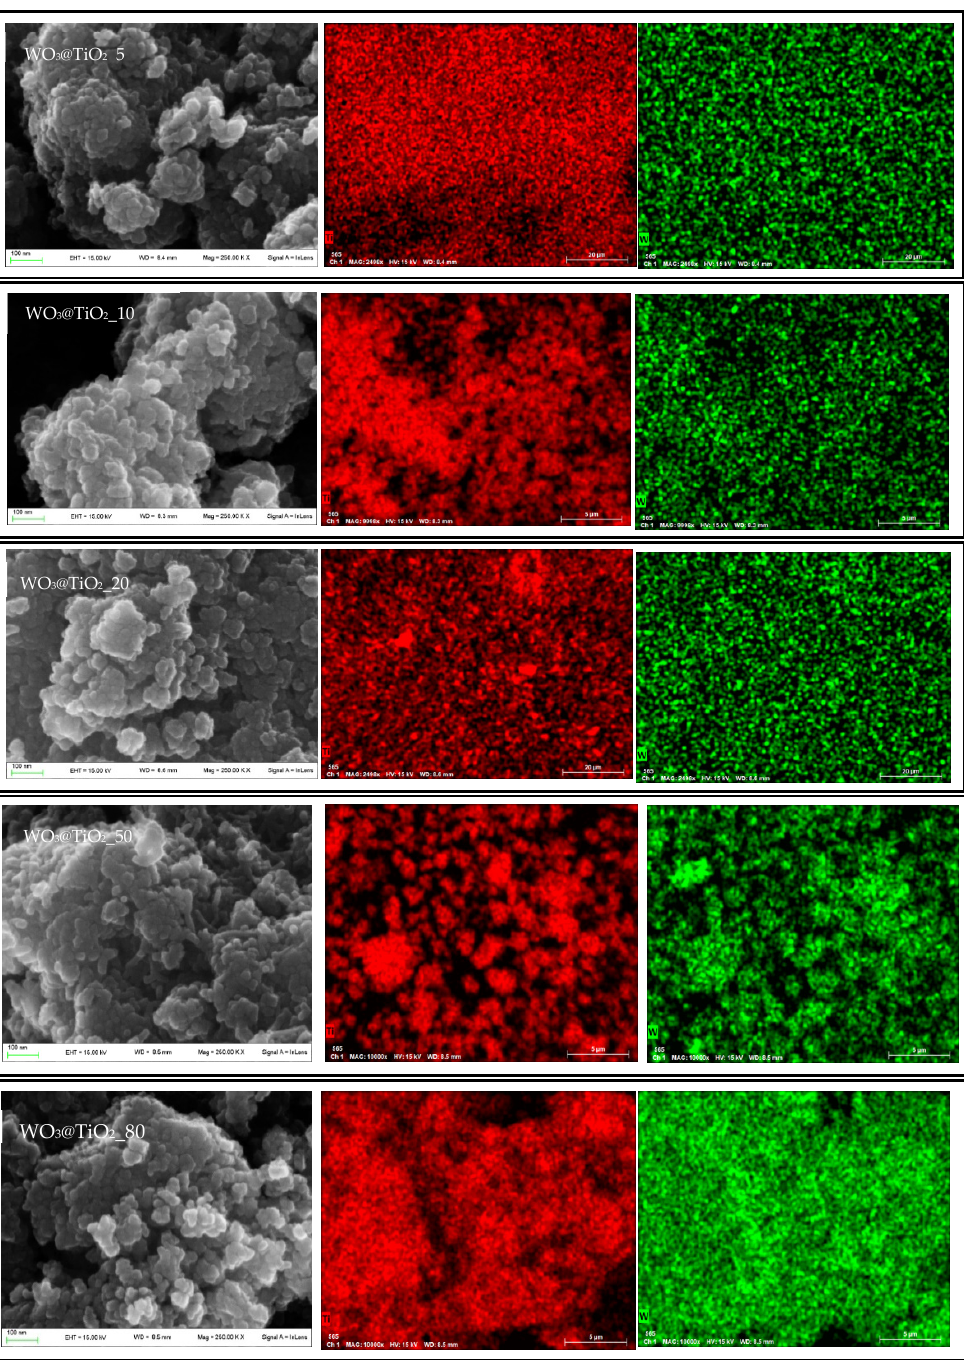
Figure 6. SEM images and elemental mapping of the synthesized materials. ( left ) sample analyzed, ( middle , red-colored) titanium map, ( right , green-colored) tungsten map. The elemental maps of W and Ti by X-ray energy dispersion (EDX) in the composites demonstrate that TiO 2 and WO 3 are well dispersed in each material. All the WO 3 @TiO 2 show a globular-like morphology with particle sizes ranging from 60 to 5 nm. The particles are aggregated by sharing corners or edges that probably involve the formation of Ti– O–W bonds [44]. The same information was obtained by TEM investigations (Figure 7) showing nanoparticles of 12–35 nm that gradually aggregate with the WO 3 load, reaching up to 60 nm in size.